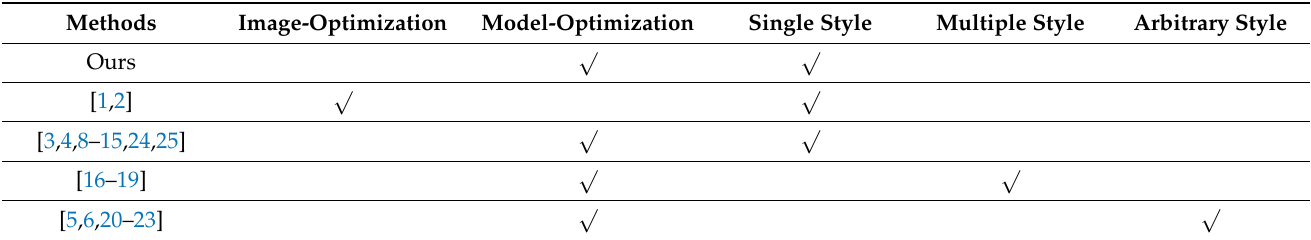
Table 1. The differences between our method and those in previous